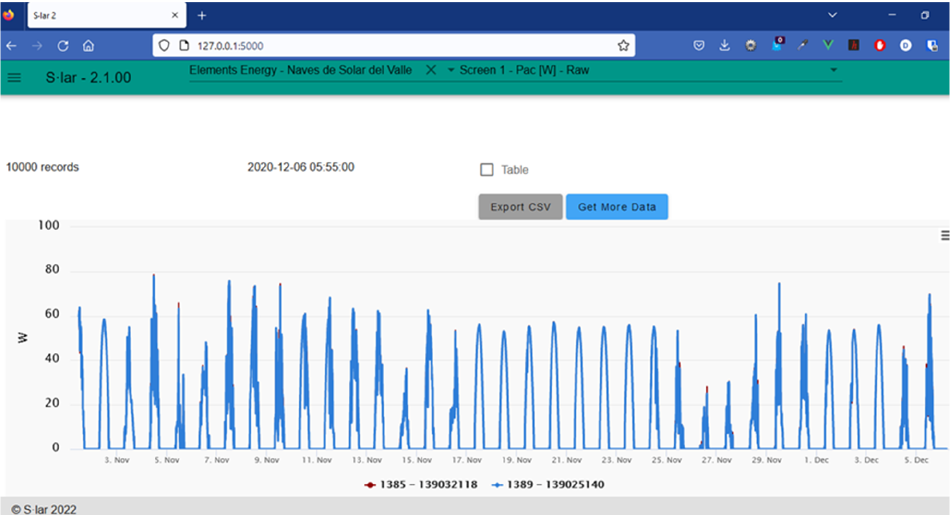
Figure 9. Image of the S·lar 2 application screen, showing a graphical representation of the power in the output of the two selected inverters ( P ac ) for the chosen time period.